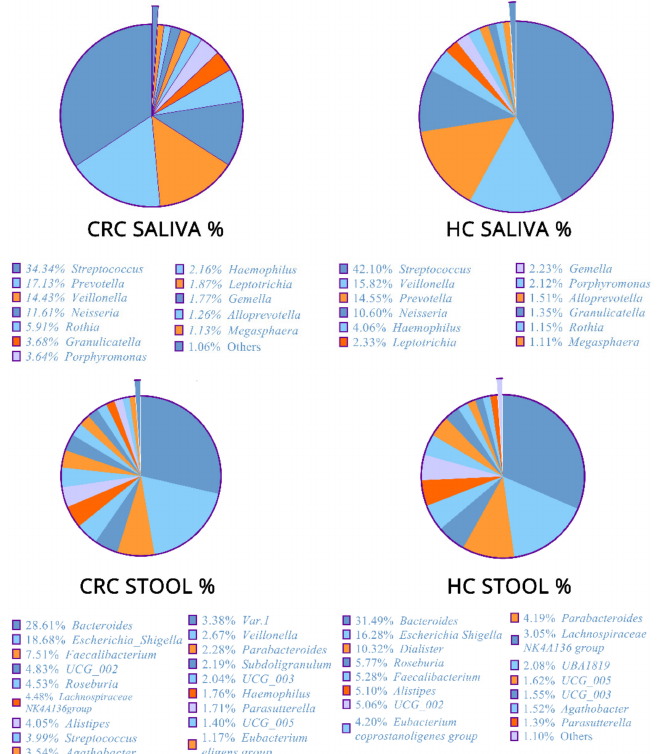
Figure 1. Composition of bacteria and the relative differential abundance of the bacterial genera in fecal and saliva samples of colorectal cancer (CRC) patients and healthy controls